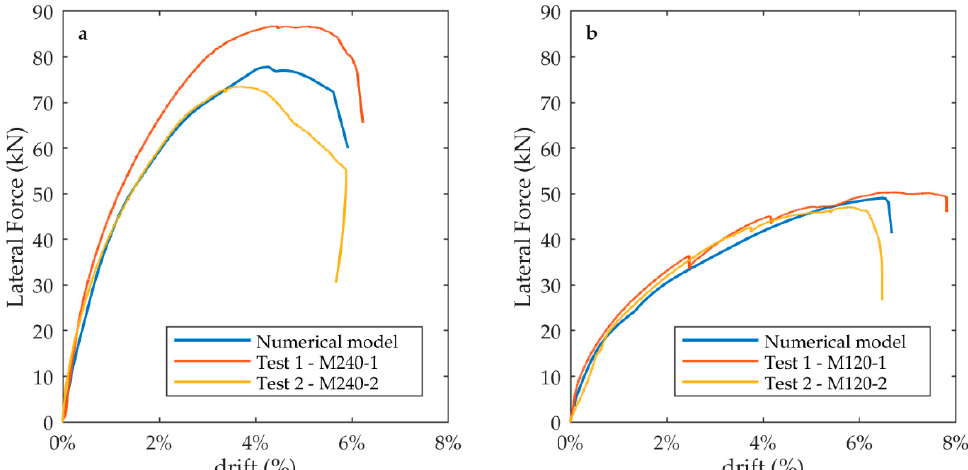
Figure A3. Capacity curve comparison for the tested walls reported by Estrella et al., 2020 [21] and the models developed under our approach calibrated using the sheathing-to-framing test results: ( a ) 2.4 m length wall; ( b ) 1.2 m length wall.